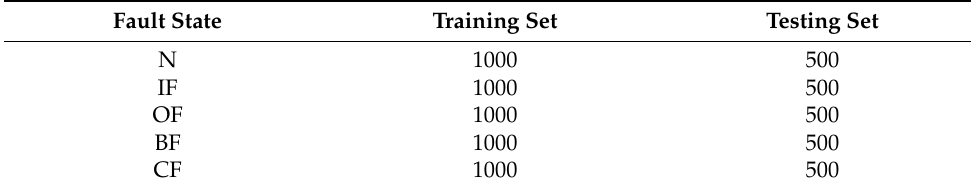
Table 7. Bearing failure sample data set.